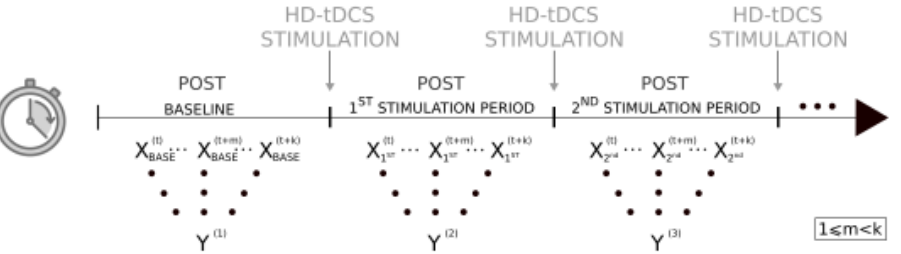
Figure 2. Visual representation of the data transformation method in which fixing a time window t , the impact of one time series into the other, represented by ( X ( t ) ), is summarized into entropy index ( Y ( t ) ). For each experiment period, the transfer entropy calculation was done per segmentation (time window), which transformed the exchanged information (causal direction) between one platform into a complexity measure value (entropy index). The entropy index calculated the causal effect from the right-side to the left-side of a time segment, as well the effect of the same time segment from the left-side to the